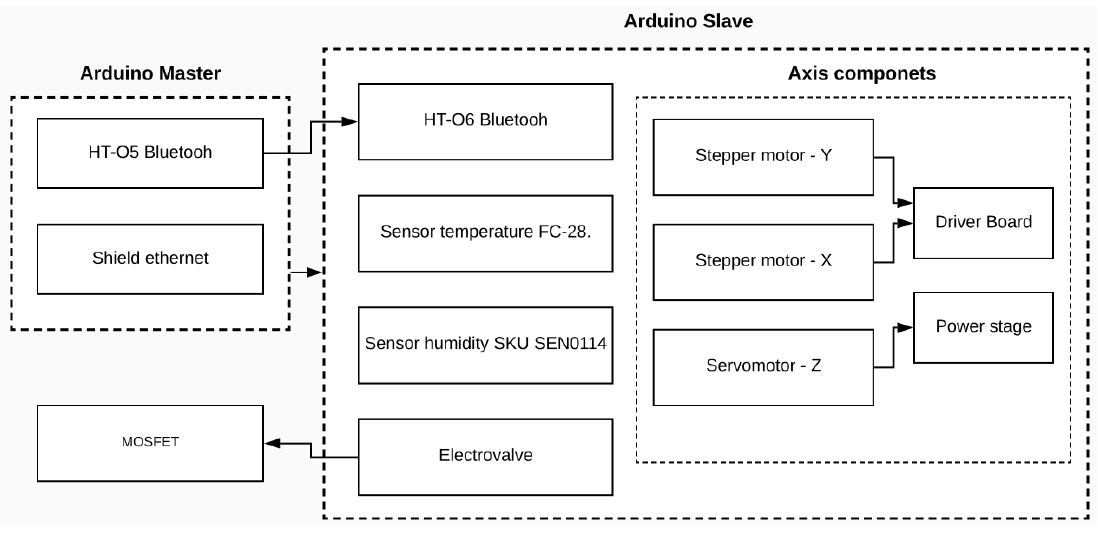
Figure 2: Electronic devices in the